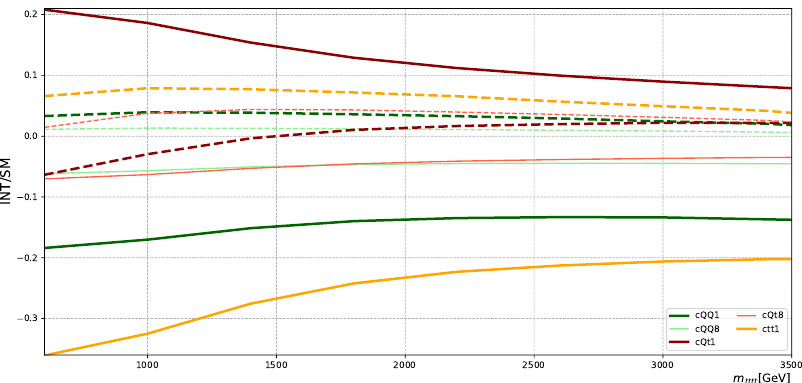
Figure 12 . The ratio of the linear EFT interference to the SM prediction for the non-naive 4- heavy operators. Solid lines depict the O ( α 2 one. Thick (thin) lines represent colour-singlets